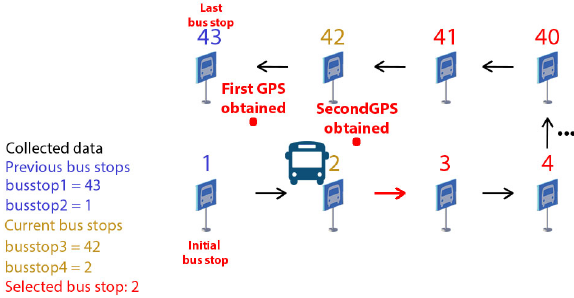
Figure 6. GPS Sensor Error Correction